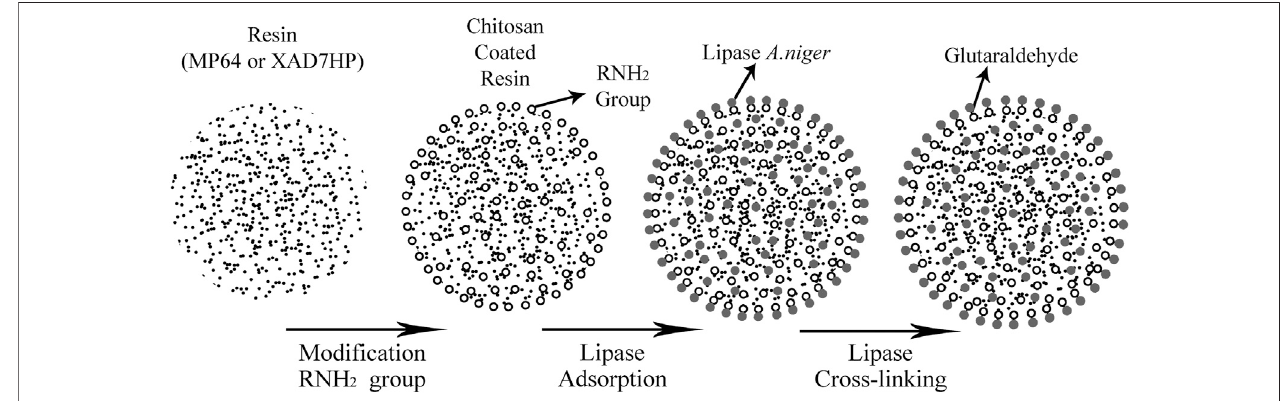
FIGURE 3 | Scheme Aspergillus niger lipase immobilization process by